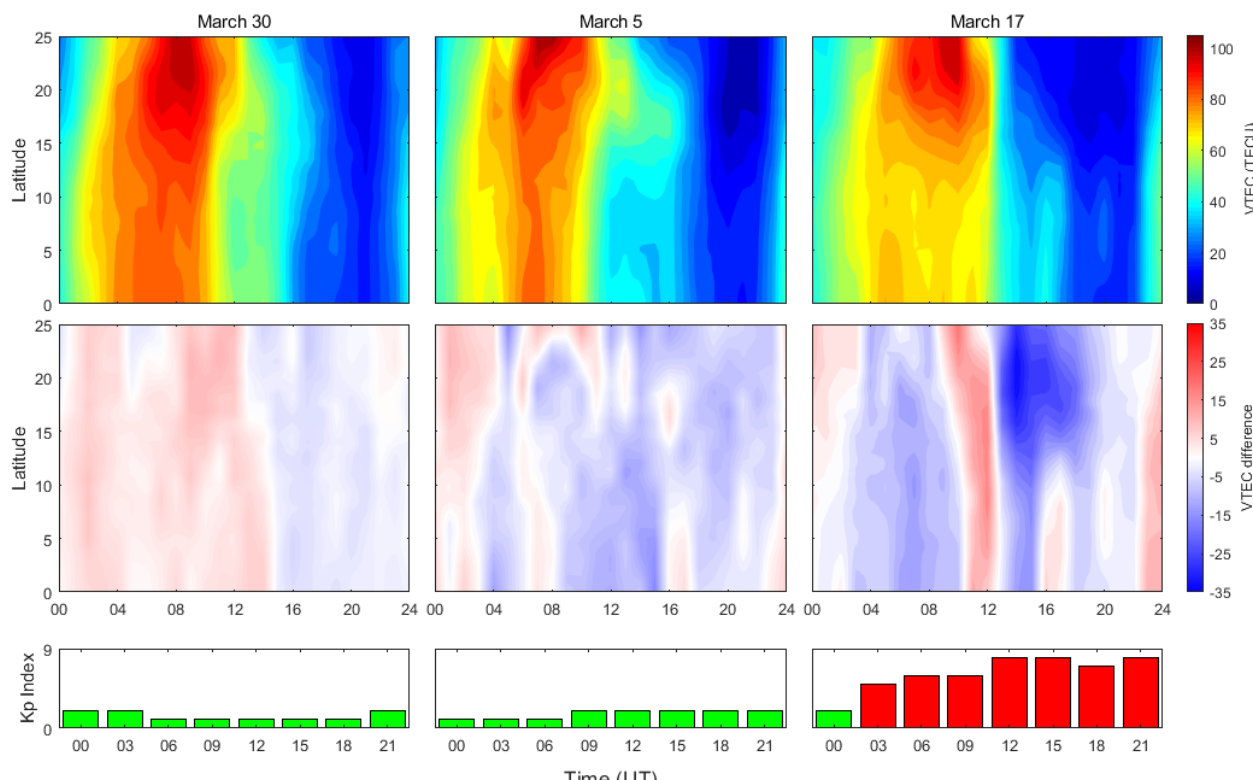
Figure 13. Latitude profiles of 30 March, 5 March and 17 March with the difference between them and the latitude profiles of quiet day VTEC plus Kp-index bar graph.